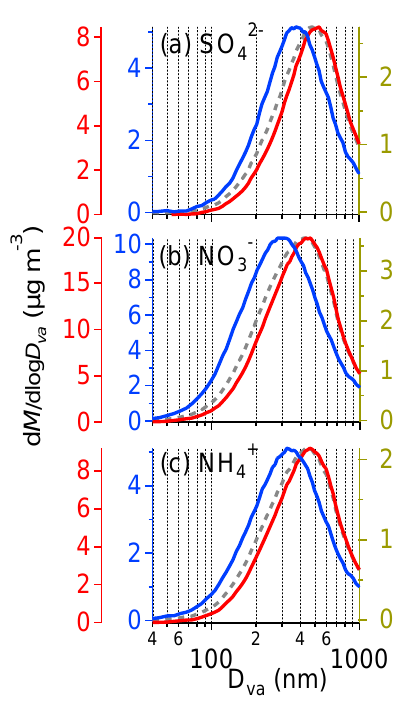
Figure 13. Averaged mass-based size distributions of (a) sulfate, (b) nitrate, and (c) ammonium during the entire (broken grey curve) high-PM (red curve) and low-PM (blue curve) periods as marked in Figs. 2 and Figure 13. 23